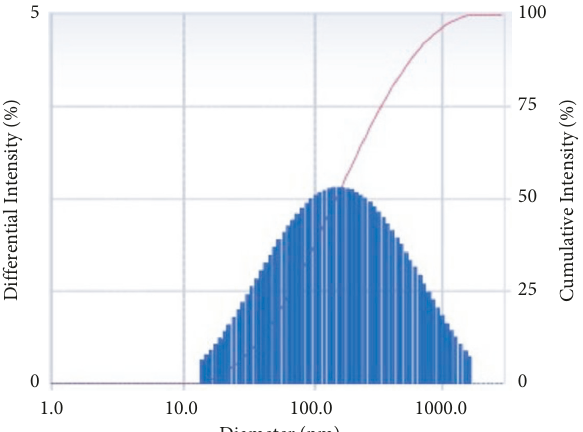
Figure 3: DLS spectrum of SP-ZnONPs.